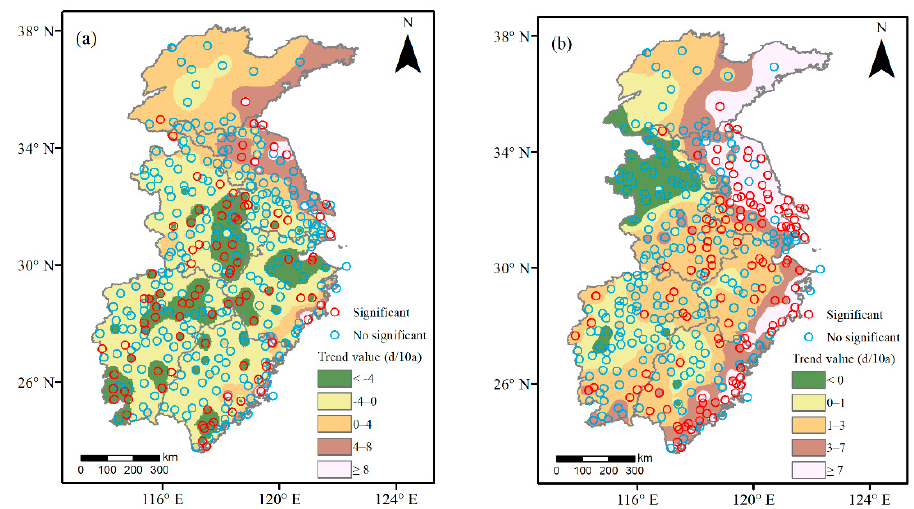
Figure 10. Distribution of the climate tendency rate of the mean ( a ) first and ( b ) last extreme maximum temperature event days in East China during the period 1961–2020.